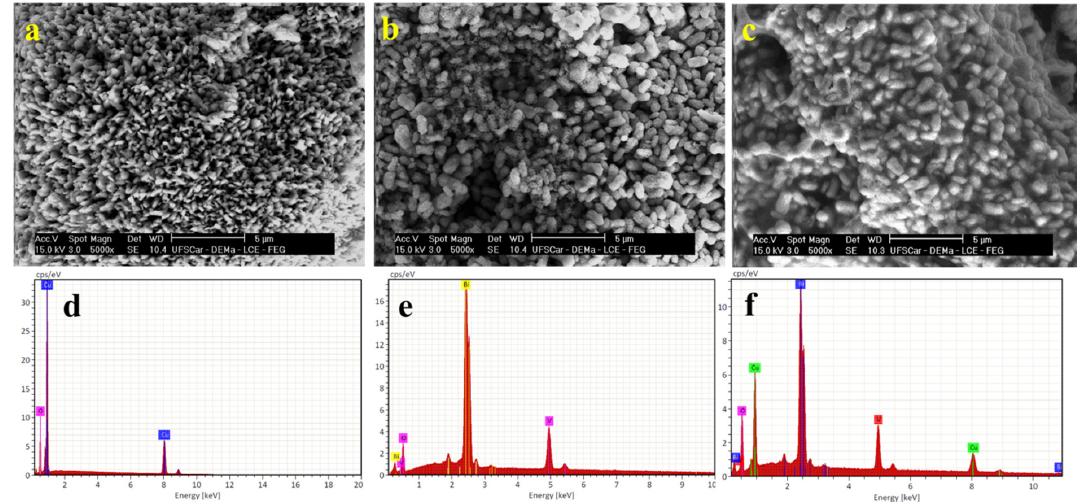
Figure 2. SEM micrographs of the ( a ) CuO; ( b ) BiVO 4 ; and ( c ) BiVO 4 . Respective EDS data of ( d ) CuO; ( e ) BiVO 4 ; and ( f ) BiVO 4.